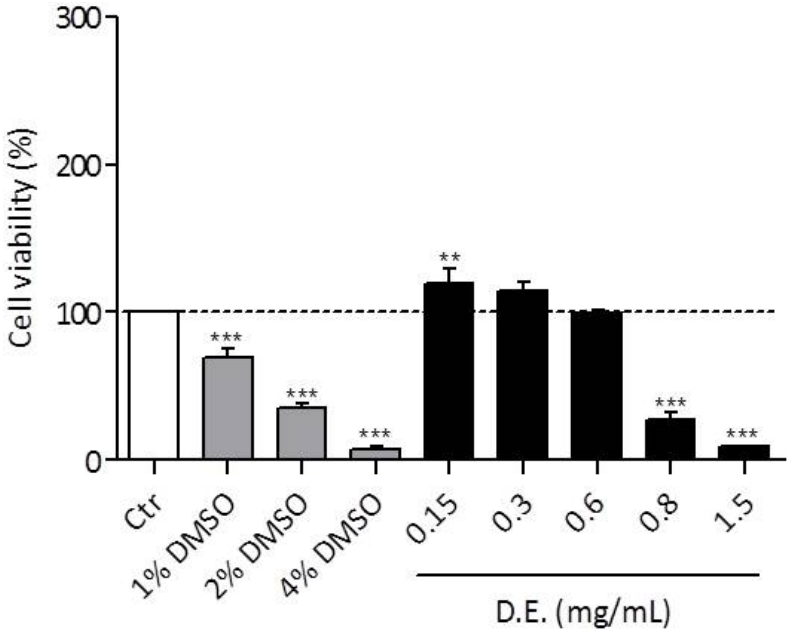
Figure 10. Viability measured in vitro on HaCaT cells for different D.E. concentrations. Ctr, untreated cells in DMEM was set at 100%, three different percentages (1%, 2% and 4%) of DMSO were used as positive controls. ** p < 0.001, *** p < 0.0001, D.E. vs. Ctr (One-way ANOVA test).